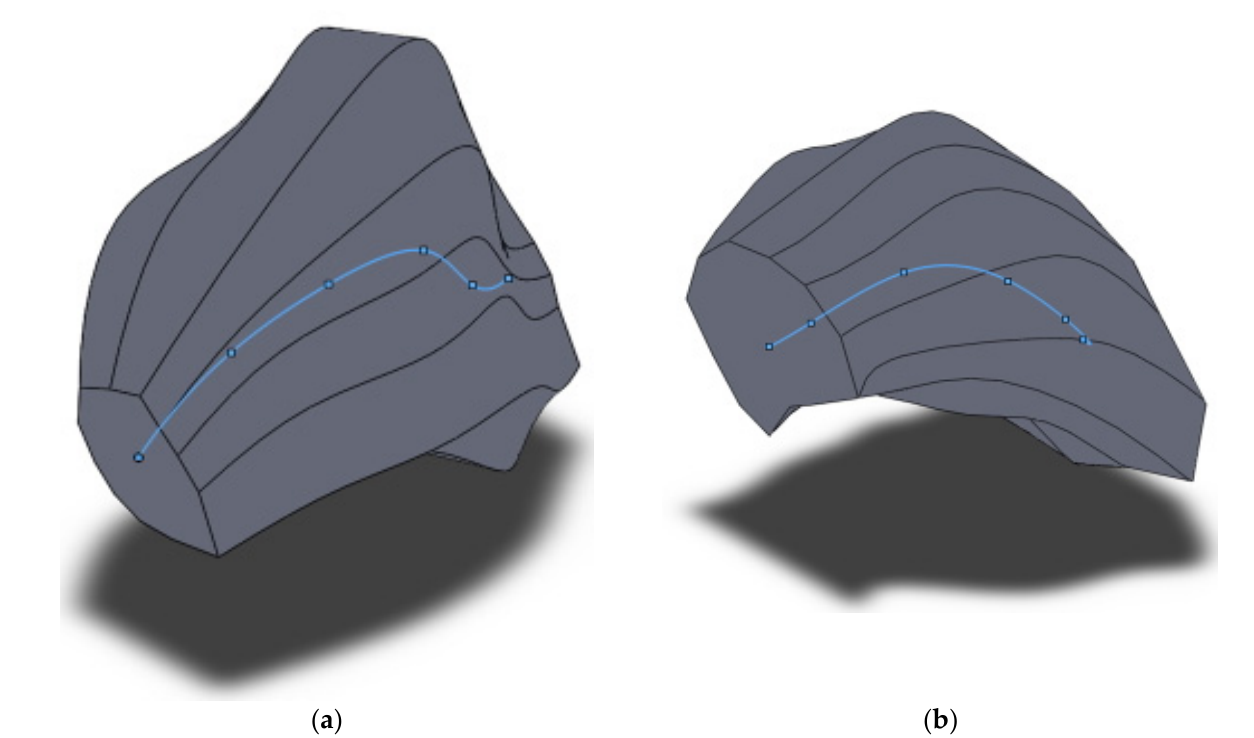
Materials 2022 , 15 , x FOR PEER REVIEW